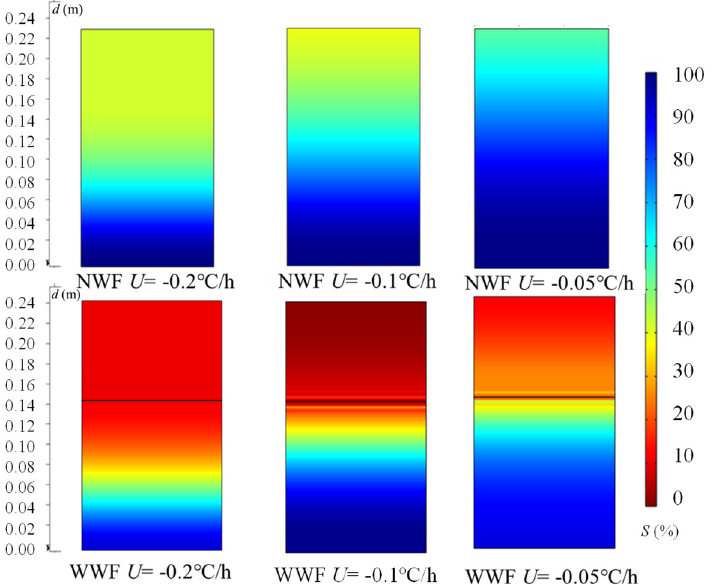
Figure 15. Comparison of saturation distribution between NWF model and WWF model in the freezing process.